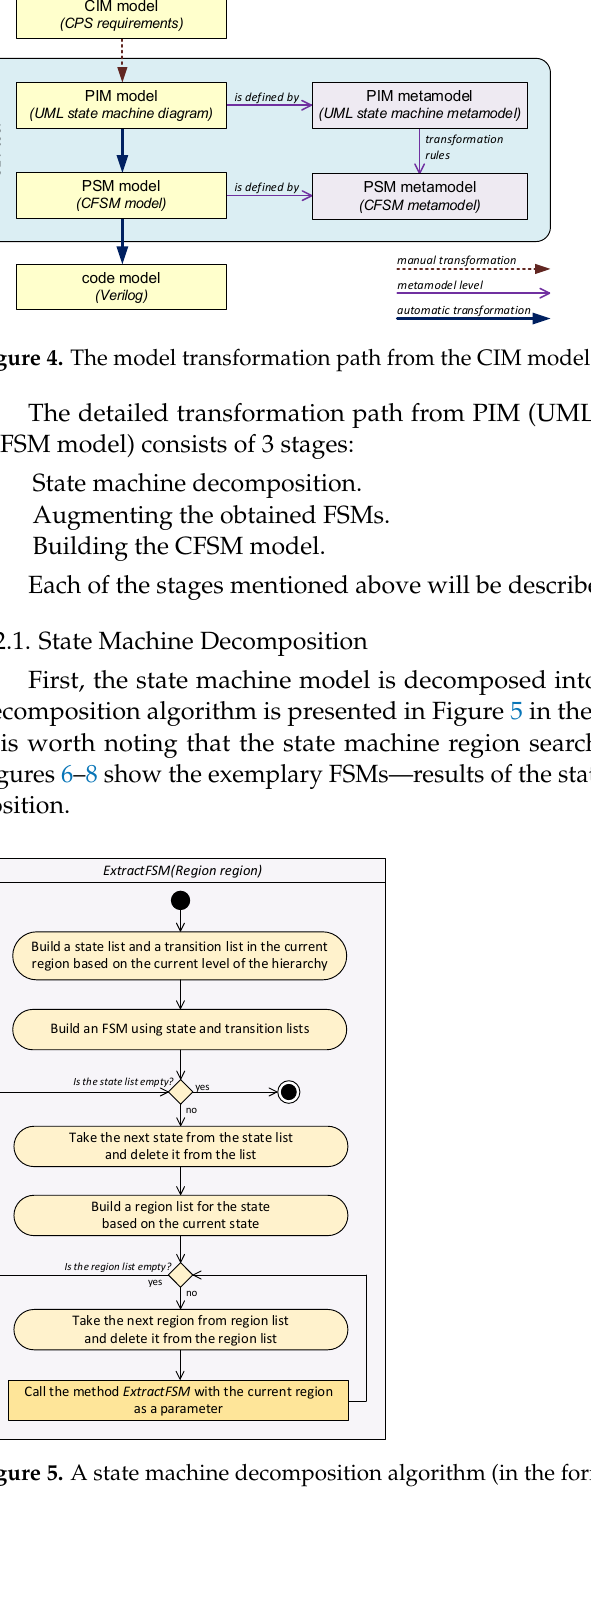
Figure 6. Master FSM ( Process ).